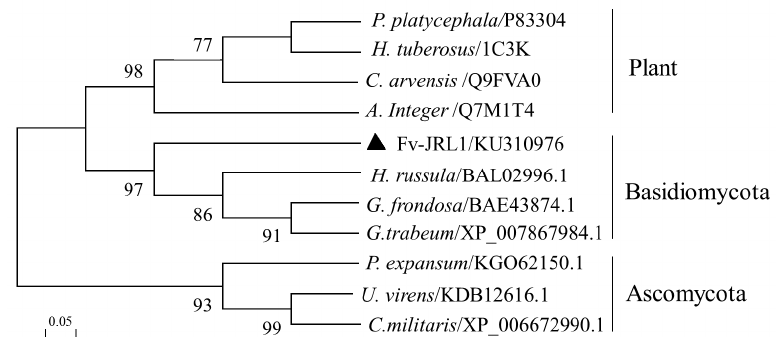
Figure 1. Phylogenetic analysis of Fv-JRL1 with amino acid sequences of JRL1 identified from different organisms. P. platycephala , Parkia platycephala ; H. Tuberosus , Helianthus Tuberosus ; C. arvensis , Convolvulus arvensis ; A. integer , Artocarpus integer ; H. russula , Hygrophorus russula ; G. trabeum , Gloeophyllum trabeum ; G. frondosa , Grifola frondosa ; P. expansum , Penicillium expansum ; U. virens , Ustilaginoidea virens ; C. militaris